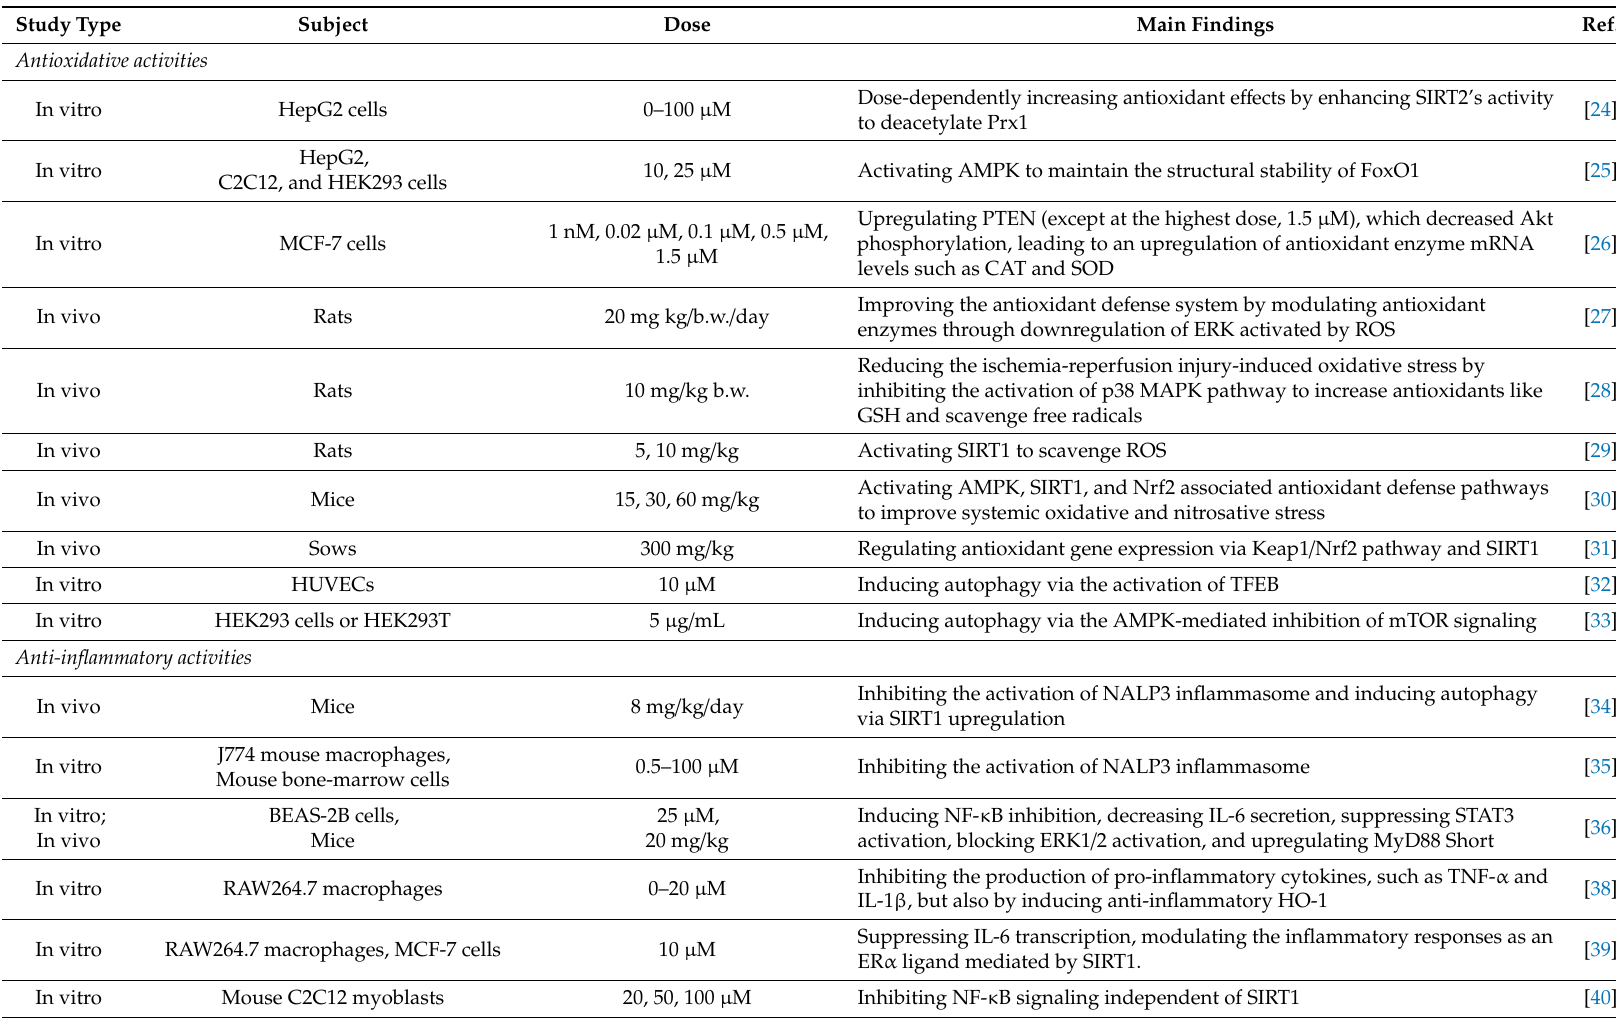
Table 2. Bioactivities and potential mechanisms of resveratrol from experimental